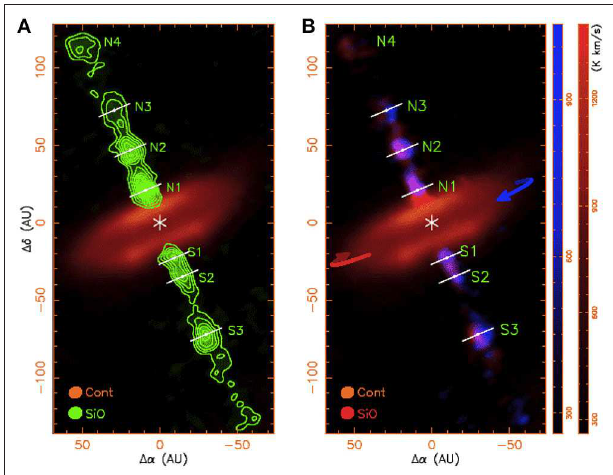
FIGURE 2 | ALMA observations of the rotating outflows of the class 0 protostar HH212. Shown is a zoom-in to the innermost part of the jet in SiO within 120 au of the central source, at a resolution of 8au on top of the ≈ ≈ continuum map of the disk. The maps show the intensity (in unit of Kkm s − 1 ) integrated over certain velocity range. (A) A chain of new knots trace the primary jet emanating from the disk, observed in SiO. (B) Blueshifted and redshifted SiO emission of the jet plotted with the continuum emission. Direction of rotation is shown with arrows. From Lee et al. (2017) reproduced with permission c Springer (cid:13)